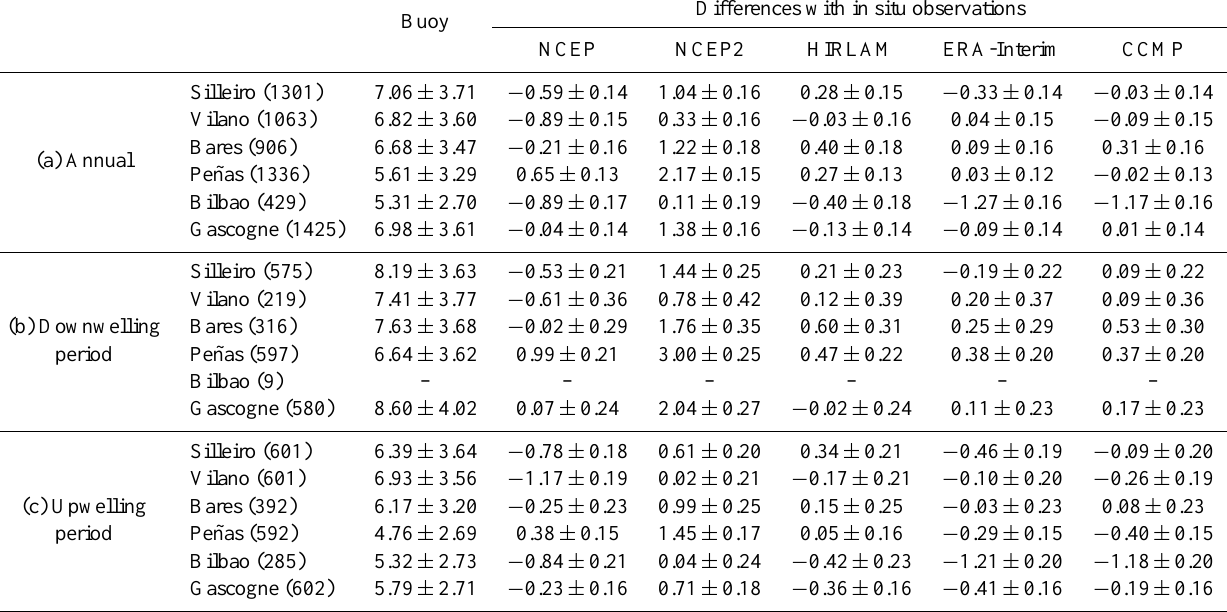
Table 1. Mean (and standard deviation) observed wind speeds and the mean difference (and standard deviation of the difference) of the models from observations during the complete study period (a), during the downwelling season, defined here from October to February (b) and the upwelling season, defined from April to August (c). The number of pairs compared at each buoy is shown in brackets. Units are ms − 1